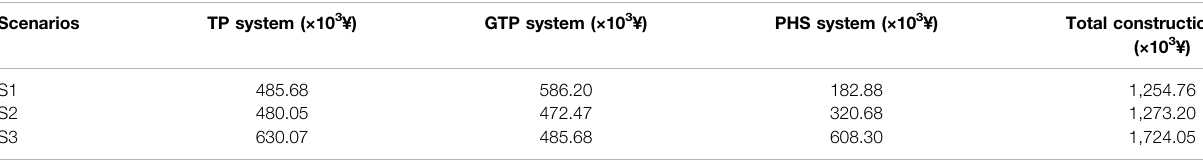
TABLE 3 | Construction cost for each scenario.